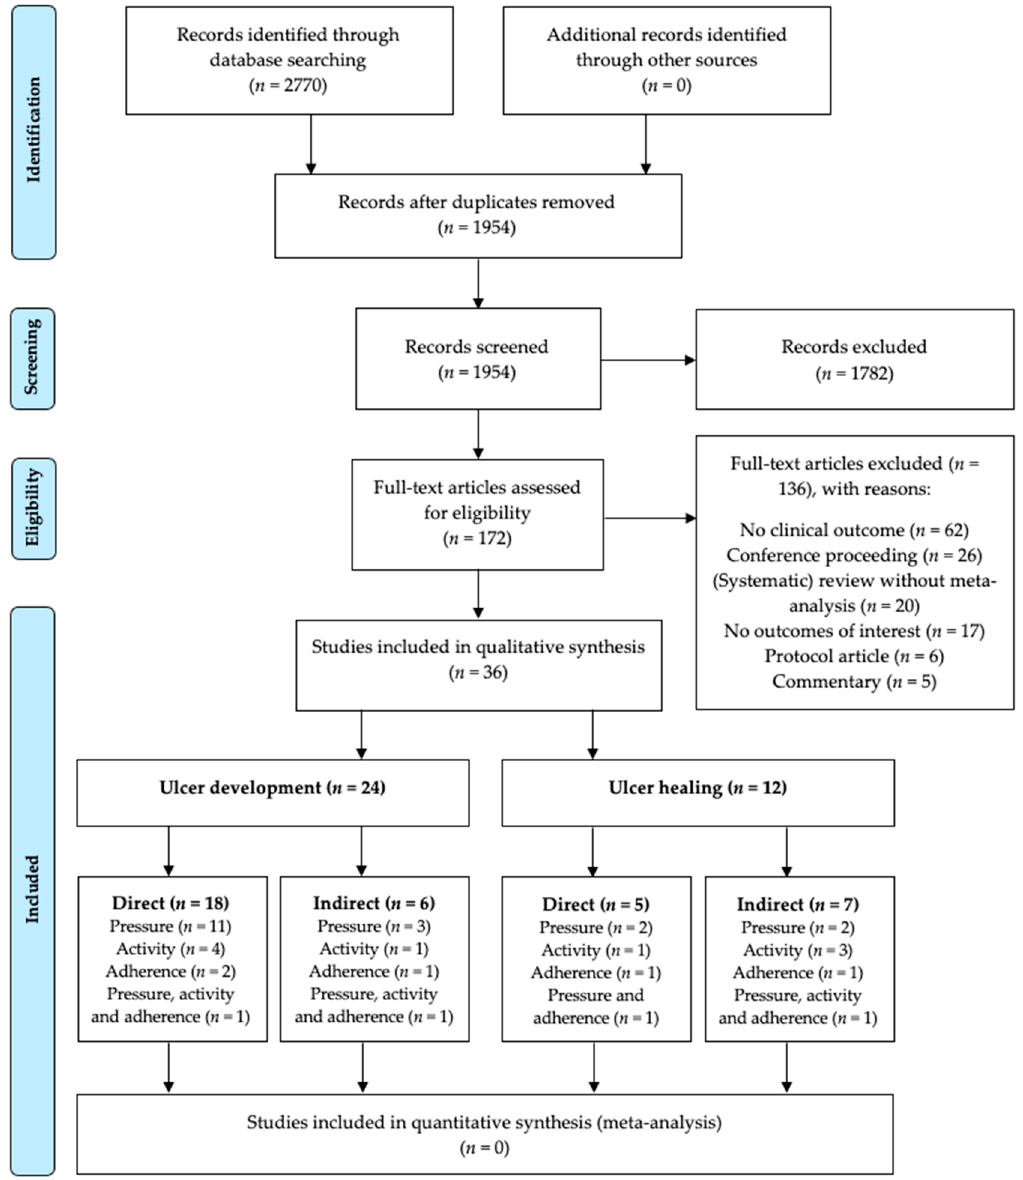
Figure 1. PRISMA flow diagram.